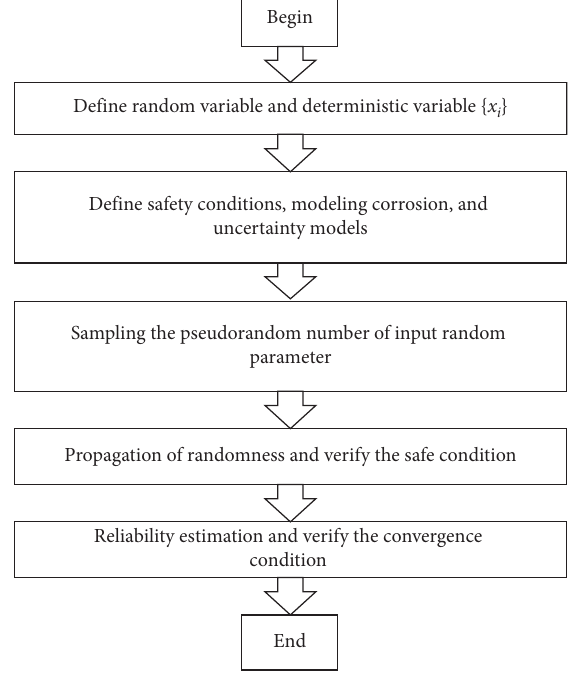
Figure 4: Flowchart of the reliability assessment of SCC beams using Monte Carlo simulation.